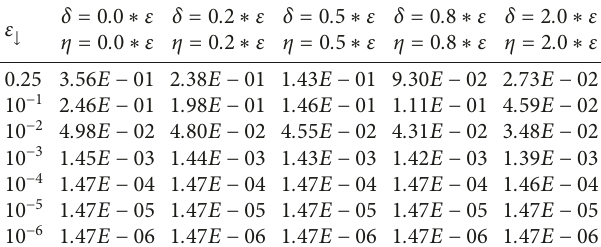
Figure 1: Approximate solution of Example 1 for different values of δ . Table 2: Result for Example 2 (max. errors for N � 100).